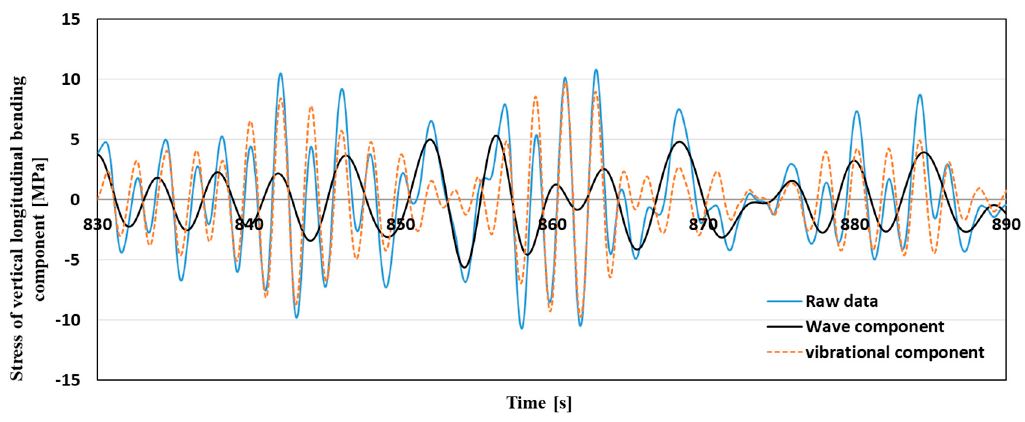
Figure 12. Time-series stress data during 830–890 s of the vertical longitudinal bending component.